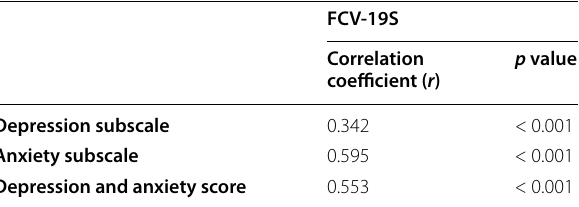
Table 5 Correlation between depression, anxiety subscales of HADS, and the total score with